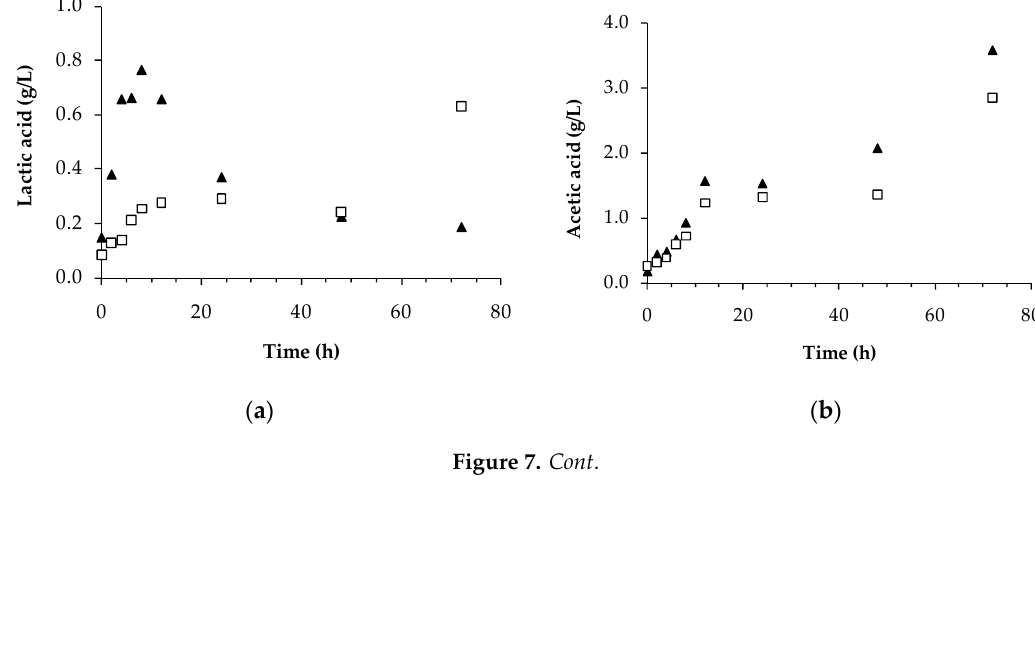
Figure 6. pH during syngas fermentation by C. carboxidivorans on Tryptone-Peptone-Yeast extract- Glucose-Arginine medium (TPYGarg) ( ▲ ) and ATCC ® 2713 ( □ ).